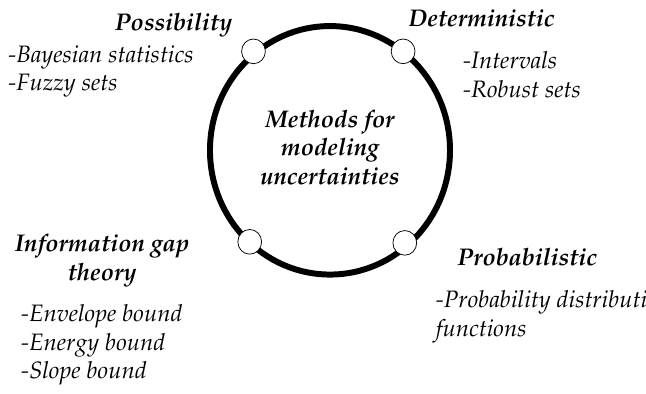
Figure 1. Common modeling